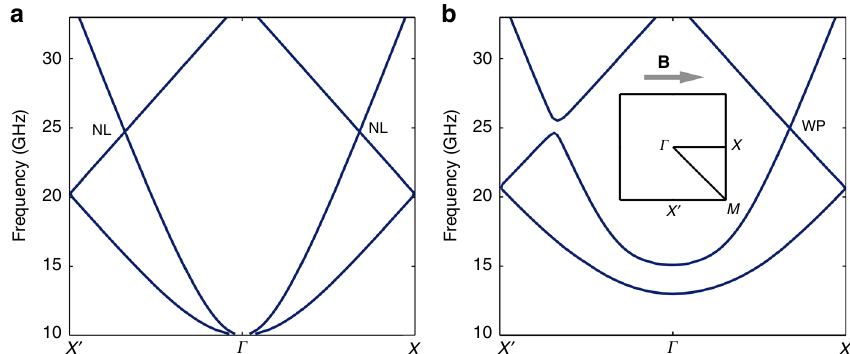
Fig. 4 Transformation from nodal line to Weyl points. a When only plasma is applied to the metacrystal without a biased magnetic fi eld, the nodal line (NL) is still present, but blue-shifted to 25 GHz. The plasma frequency is 10 GHz, rendering a photonic band gap at lower frequencies. b A magnetic fi eld is applied parallel to the Γ – X direction, as shown in the inset. This con fi guration leaves band crossings of the NL on the Γ – X high symmetry line still closed, but gapped elsewhere. Hence two type-I Weyl points are formed in the Brillouin